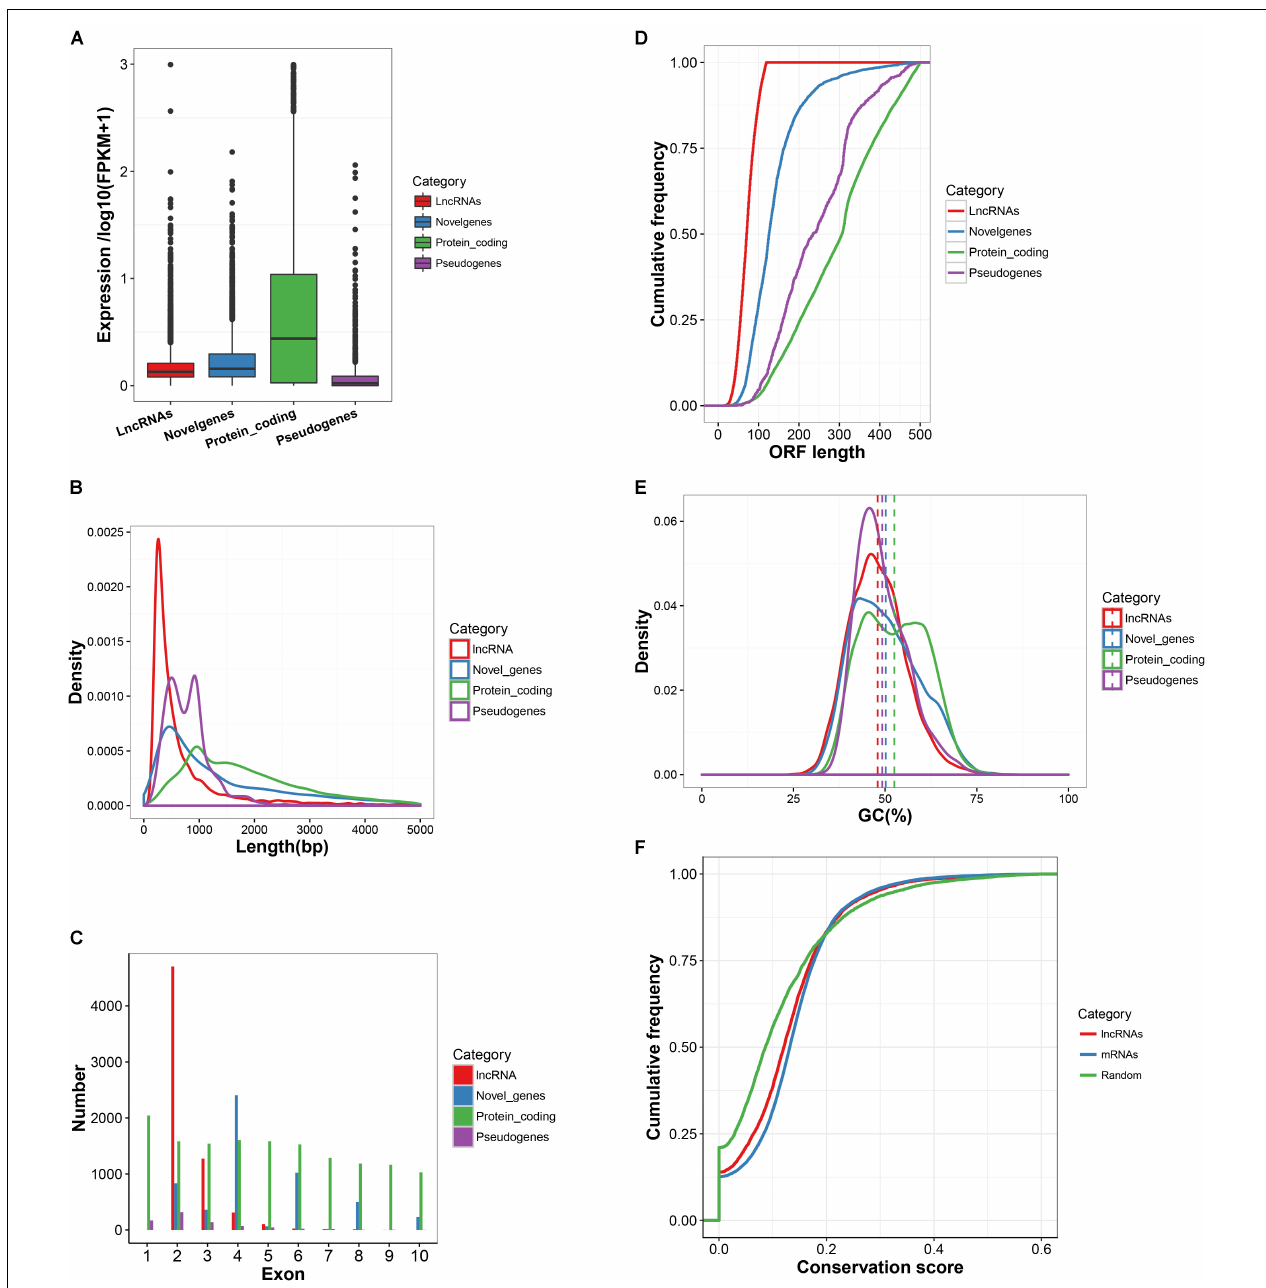
FIGURE 2 | Basic features of lncRNAs. (A) Expression level of lncRNA transcripts, marked by red box. (B) Length distribution of lncRNA transcripts, marked by red line in the Figure. (C) The number of exons for lncRNA transcripts. As marked by a red bar line in the Figure, on the average there are 2.39 exons per transcript. (D) The ORF length of lncRNA transcripts compared to protein-coding genes, novel genes and pseudo genes. (E) The GC content of lncRNAs transcripts compared to protein-coding genes, novel genes and pseudo genes. (F) LncRNA sequence conservation measured by phastCons scores. lncRNAs show intermediate sequence conservation as compared to random region and protein-coding genes.